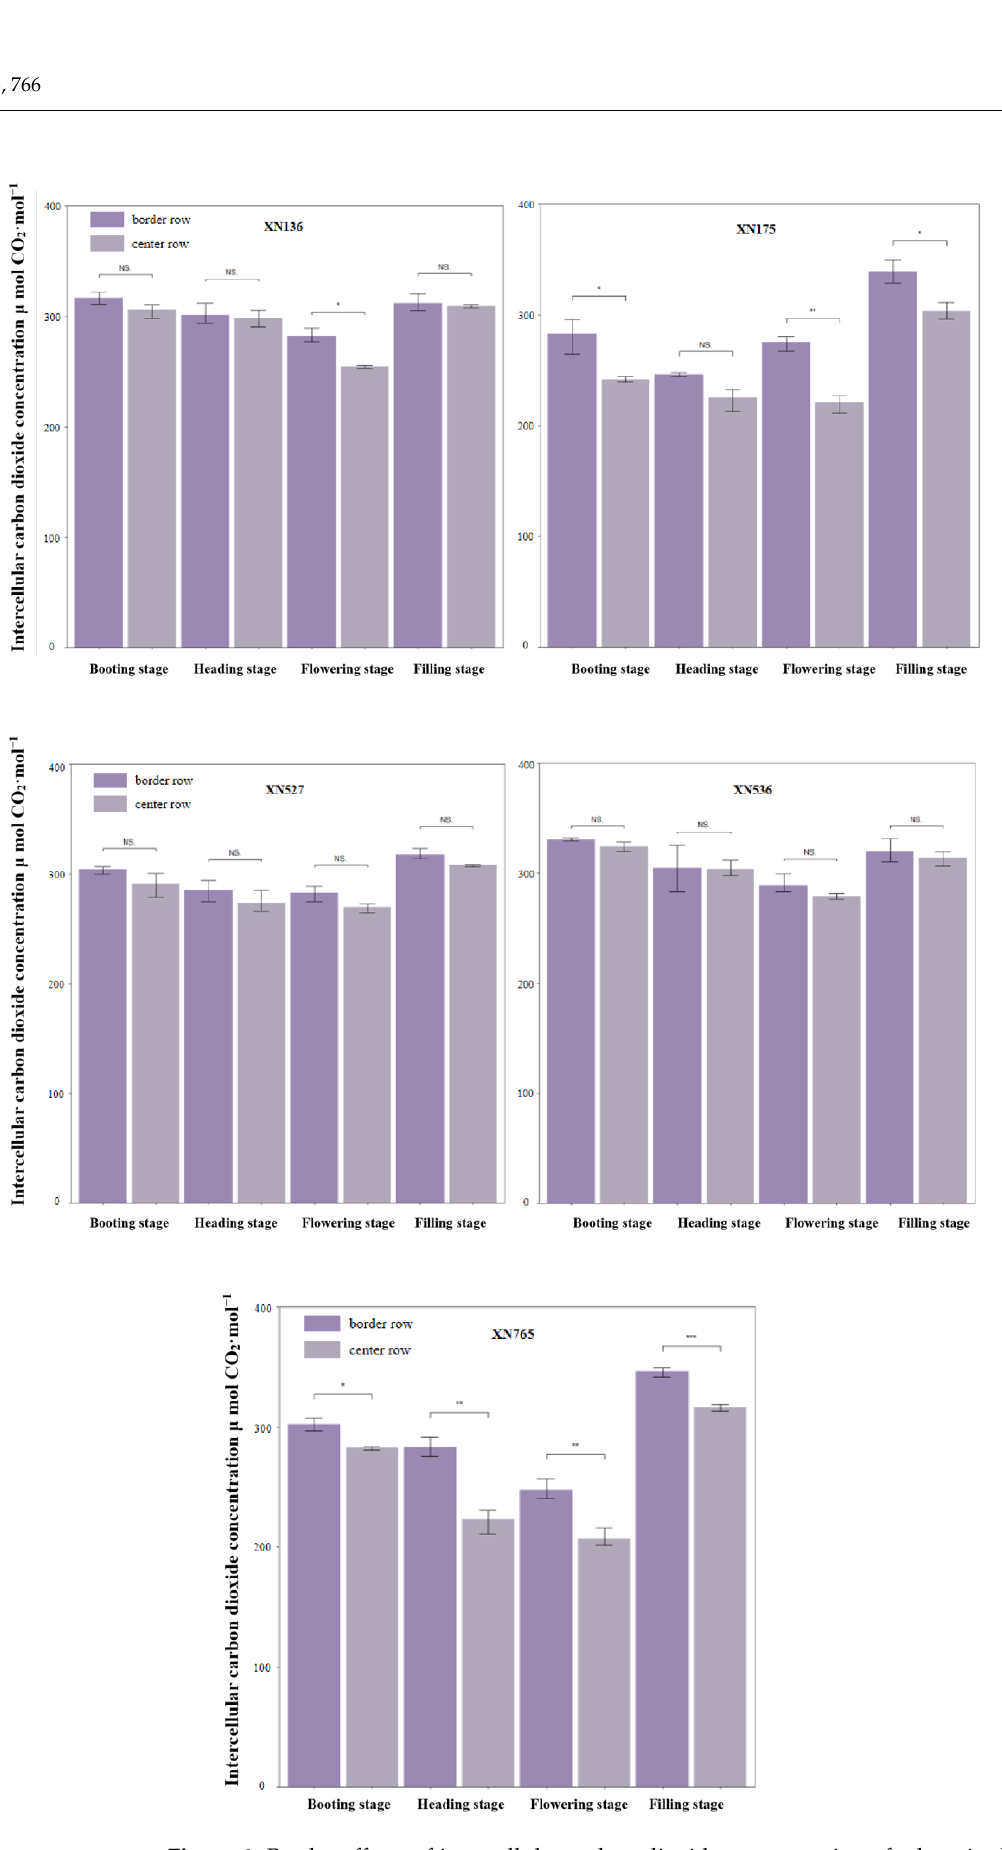
Figure 6. Border effects of intercellular carbon dioxide concentration of wheat in different